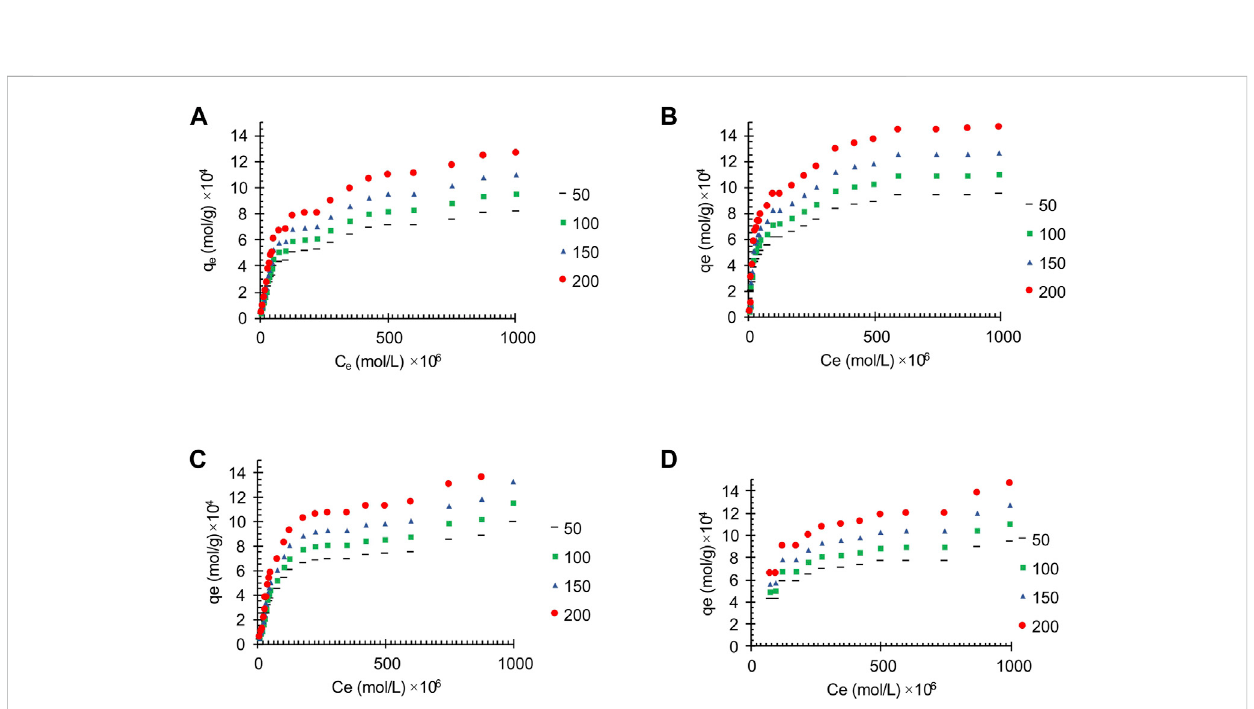
FIGURE 6 The effect of adsorbent amount on the oil adsorption of the synthesized wastewater on the activated carbon obtained from (A) Oil sludge 1; (B) Oil sludge 2; (C) Oil sludge 3; (D) Oil sludge 4 at T = 318 K and pH =